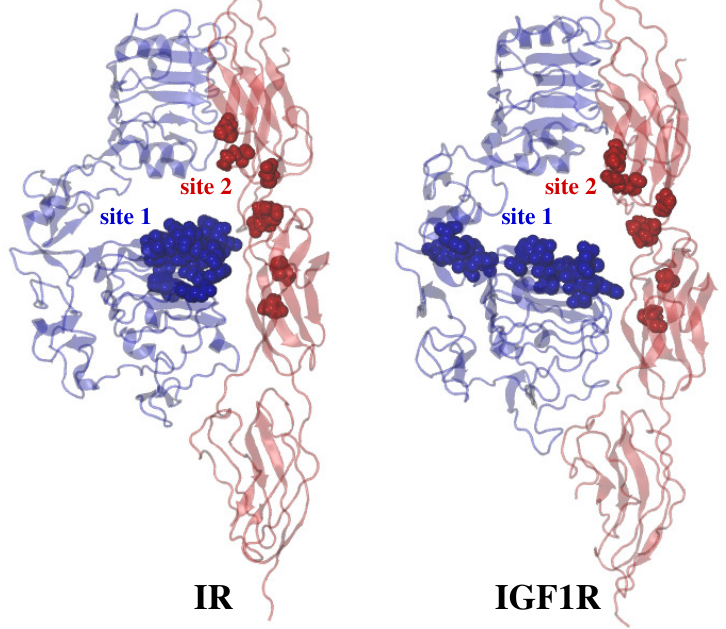
Figure 5. Site 1 and site 2 residues on IR and IGF1R. Schematic illustration of a side view of IR and IGF1R ectodomains indicating site 1 (blue) and site 2 (red) residues in space-filling representations; see Figure 4a for domain labels and the coloring scheme. Site 2 residues are located in the F1-F2 motif of each receptor, while site 1 residues span the L1 (IR) and L1-CR (IGF1R)